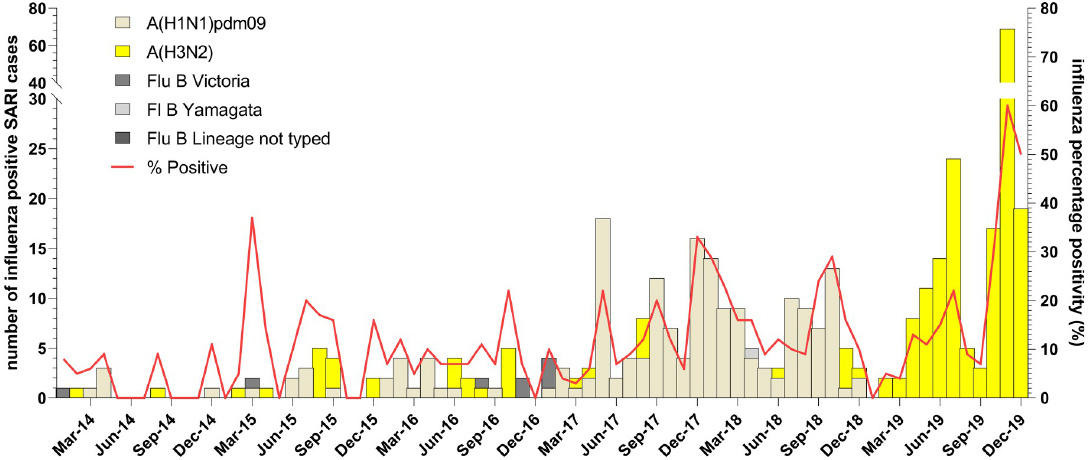
Fig 5. Distribution of influenza A subtypes and B lineages by months in Ghana from 2011 to 2019. Influenza positivity rate and the number of influenza A subtypes and B lineages was plotted against months for